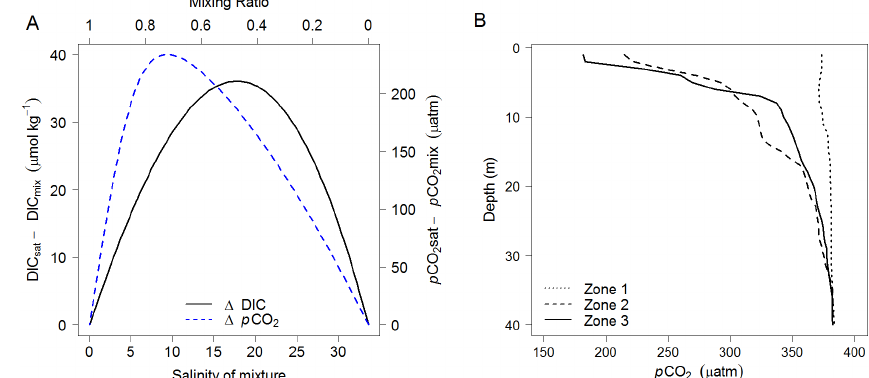
Figure 11. Panel (a) shows undersaturation created as (cid:49) DIC (in µmolkg − 1 ) and (cid:49)p CO 2 (in µatm) as a function of salinity of the mixture (and mixing ratio, x , indicating the fraction freshwater) when two water masses in equilibrium with atmosphere are mixed: a first water parcel in equilibrium with the atmosphere with TA of 50µmolkg − 1 , DIC of 81.2µmolkg − 1 , salinity of 0 and temperature of 0 ◦ C (glacial origin), and a second parcel in equilibrium with the atmosphere with TA of 2220µmolkg − 1 , DIC of 2118µmolkg − 1 , salinity of 33.65 and temperature of 0 ◦ C (fjord/sea water). Panel (b) shows the estimated p CO 2 profile calculated from the salinity profiles of August in the three different zones in the fjord